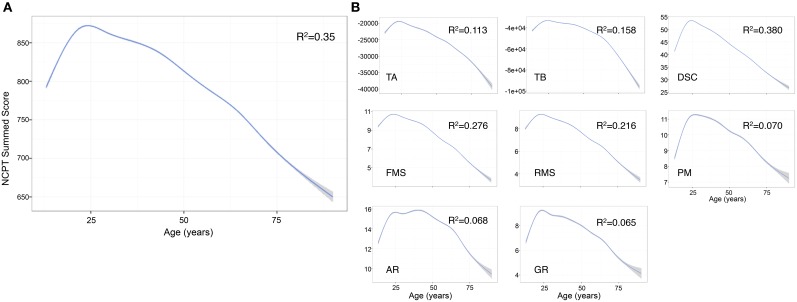
Effect of age on individual NCPT subtest scores and overall sum score. (A) The effect of age on the Grand Index was significant with peak performance occurring around age 25 and then declining in a linear fashion. (B) The effect of age on the individual subtests followed the same general trend. The decline in performance with age after 25 years appears linear for most subtests with the exception of Arithmetic Reasoning, Grammatical Reasoning, and Trail Making B. The curves were smoothed with a General Additive Model (GAM), a type of general linear model in which the linear predictor depends on linear smoothed functions (Wood, 2011). GAM was selected over a simple linear smoother because we observed that the effect of age on NCPT scores was non-linear. TA, Trail Making A; TB, Trail Making B; DSC, Digit Symbol Coding; FMS, Forward Memory Span; RMS, Reverse Memory Span; PM, Progressive Matrices; AR, Arithmetic Reasoning; GR, Grammatical Reasoning.